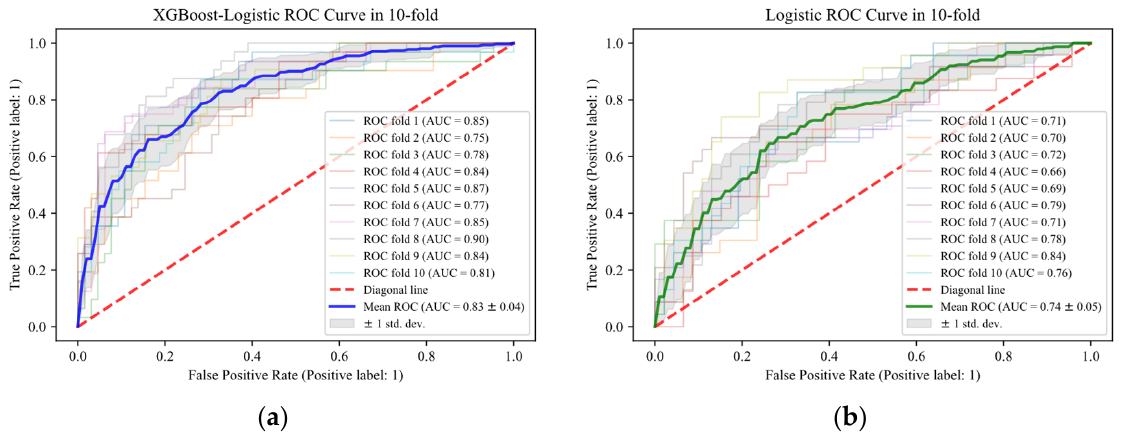
Figure 12. Comparative analysis of the K ‐ fold cross ‐ validation. ( a ) XGBoost ‐ logistic combined model; ( b ) logistic regression model.